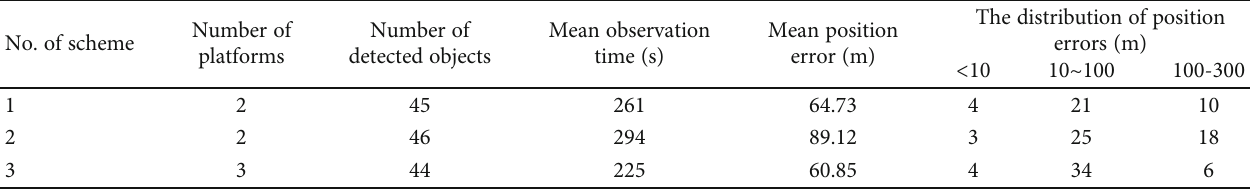
Table 10: The initial orbit determination accuracy of di ff erent